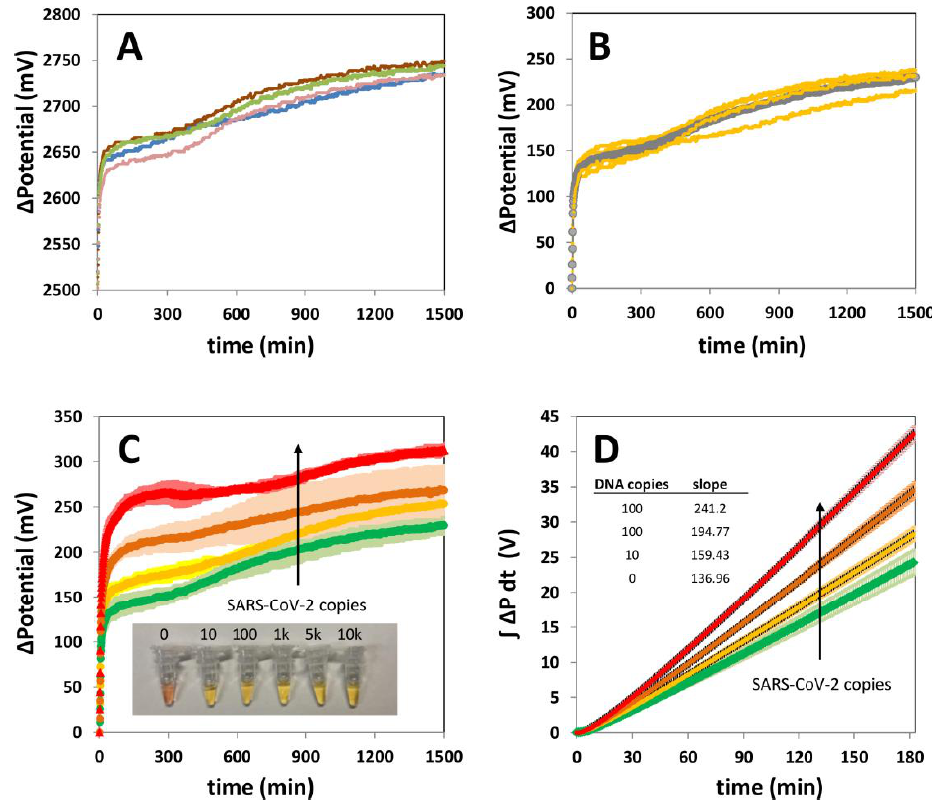
Figure 4. Discrimination between SARS-CoV-2 positive and negative saliva samples using online electric potential measurements. ( A ) Measurement of four different negative samples (i.e., samples without SARS-CoV-2 but containing reaction mix and primers). ( B ) Normalized signal of a set of four different negative saliva samples indicated with yellow lines. Values were normalized by subtracting the initial potential value of each curve. The grey line indicates the average of the four yellow trajectories (yellow lines) and is characteristic of the progression of the Loop-mediated Isother- mal Amplification (LAMP) reaction observed in negative samples. ( C ) Comparison of the online potential signal in saliva samples containing 1000 (red), 100 (orange), and 10 (yellow) copies of syn- thetic SARS-CoV-2 genetic material. The average of four negative samples is depicted in green. The inset shows a close-up of the typical end point color of a negative sample and several positive sam- ples (which contained different quantities of SARS-CoV-2 genetic material) during the amplification reaction. Shaded areas indicate standard deviations, as calculated pointwise for four independent replicates. ( D ) Plot of the average values of IP 3 (the integral of the difference of potential with respect to time for the first three minutes of amplification) in samples containing different copy numbers of synthetic SARS-CoV-2 genetic material: 1000 (red; n = 4), 100 (orange; n = 4), and 10 (yellow; n = 6) copies of synthetic SARS-CoV-2 DNA. The typical trend associated with negative samples is pre- sented in green ( n = 6). The standard deviations, as calculated pointwise for four independent rep- licates, are indicated with error bars. The values of the slope associated with each trend are pre- sented within the inset.